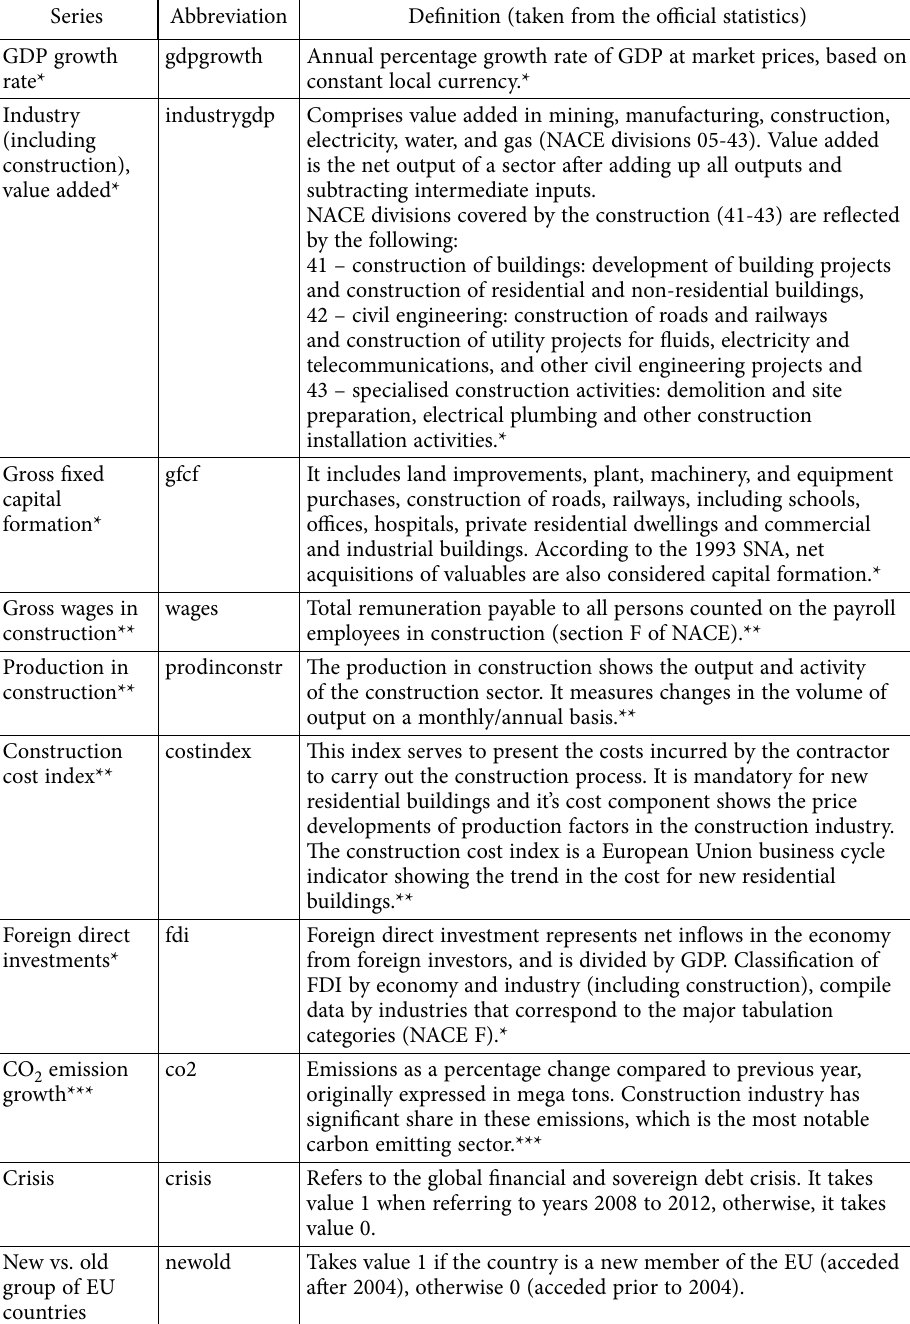
Table 1. Description and sources of data (source: *World Bank, **Eurostat, ***Our World in Data